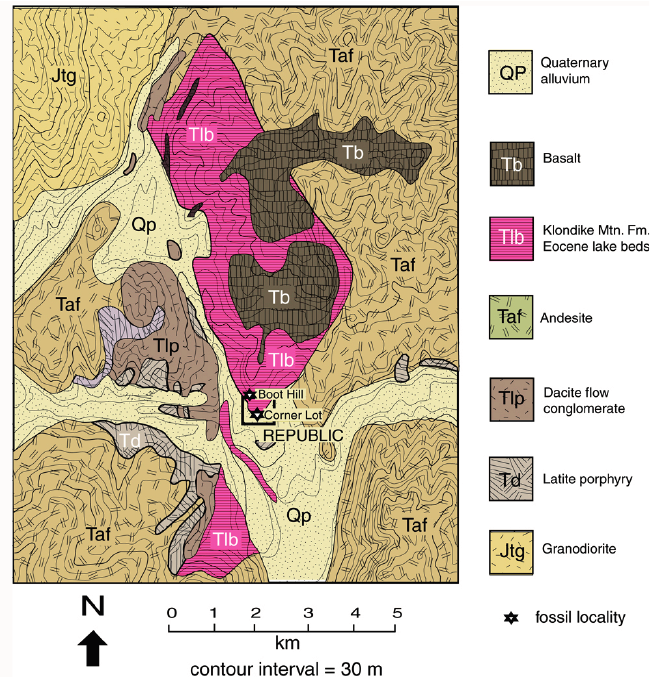
Figure 3. Geologic map of Republic area showing Stonerose Fossil Beds localities.